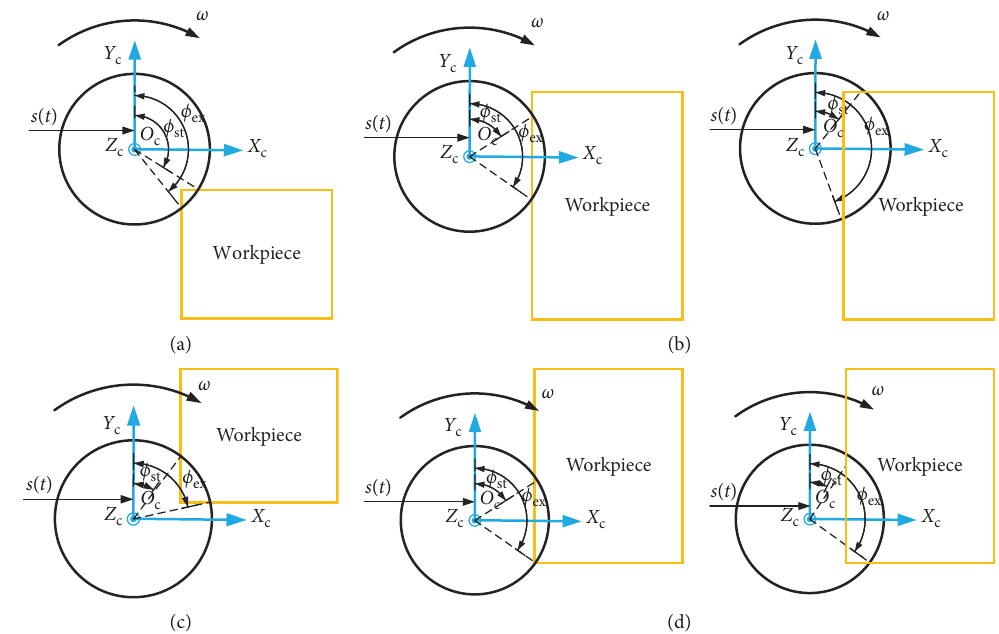
Figure 8: Calculation of the dynamic entry angle and exit angle in the entering stage. (a) a < R , up milling. (d) a (c) a e